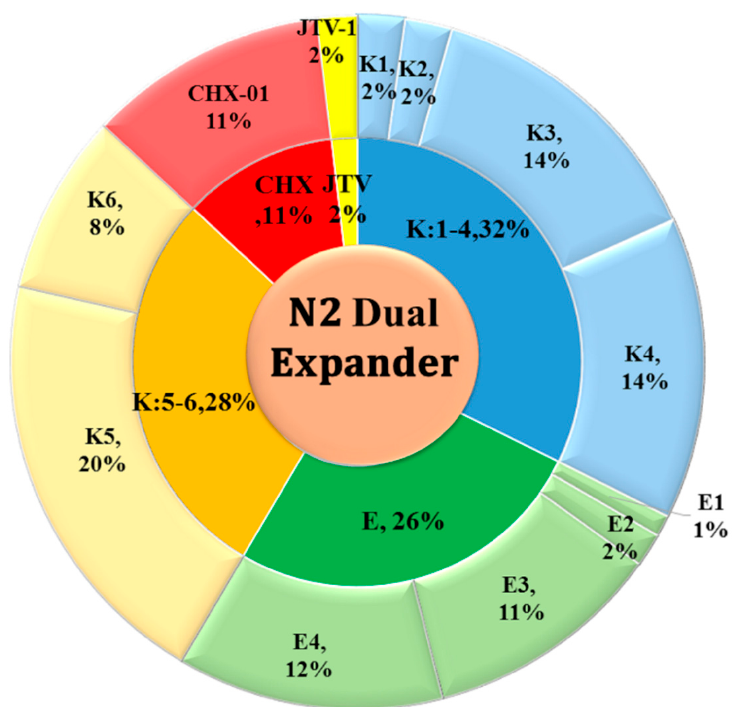
Figure 10. Percentage of exergy destruction by each equipment in the optimized case of the N 2 dual expander LNG process.